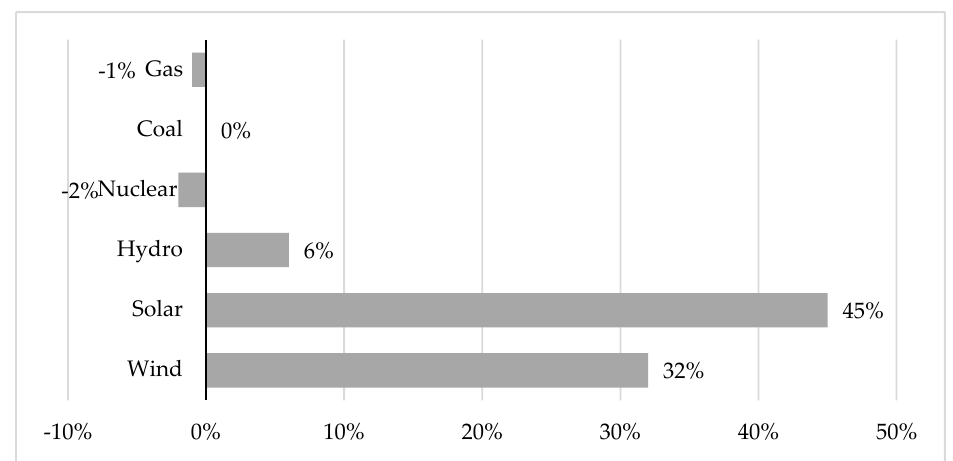
Figure 1. Global change in electricity generation technologies in 2021 relative to 2019 [3].